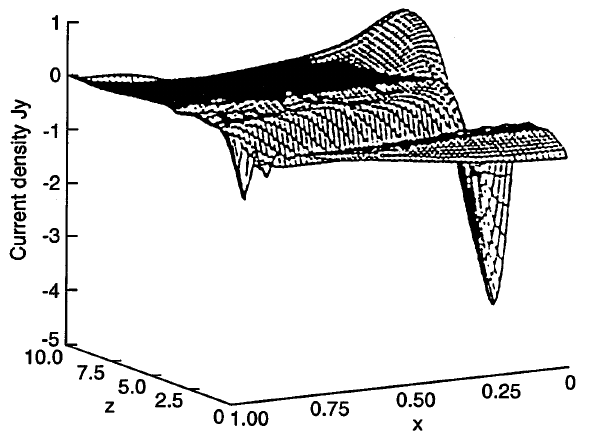
Fig. 2. 3-dimensional simulation of current sheet formation. Surface plot of the current density at y (cid:136) 0 after 70 s A showing a developing thin current sheet in the central plasma sheet due to local boundary perturbations